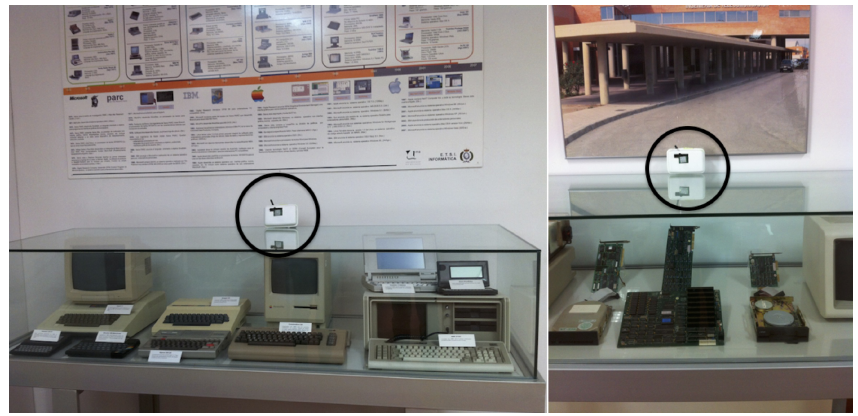
Figure 15. Screen shots of the showcases with the boxed waspmotes with infrared detection deployed in Exhibition Room 1 .